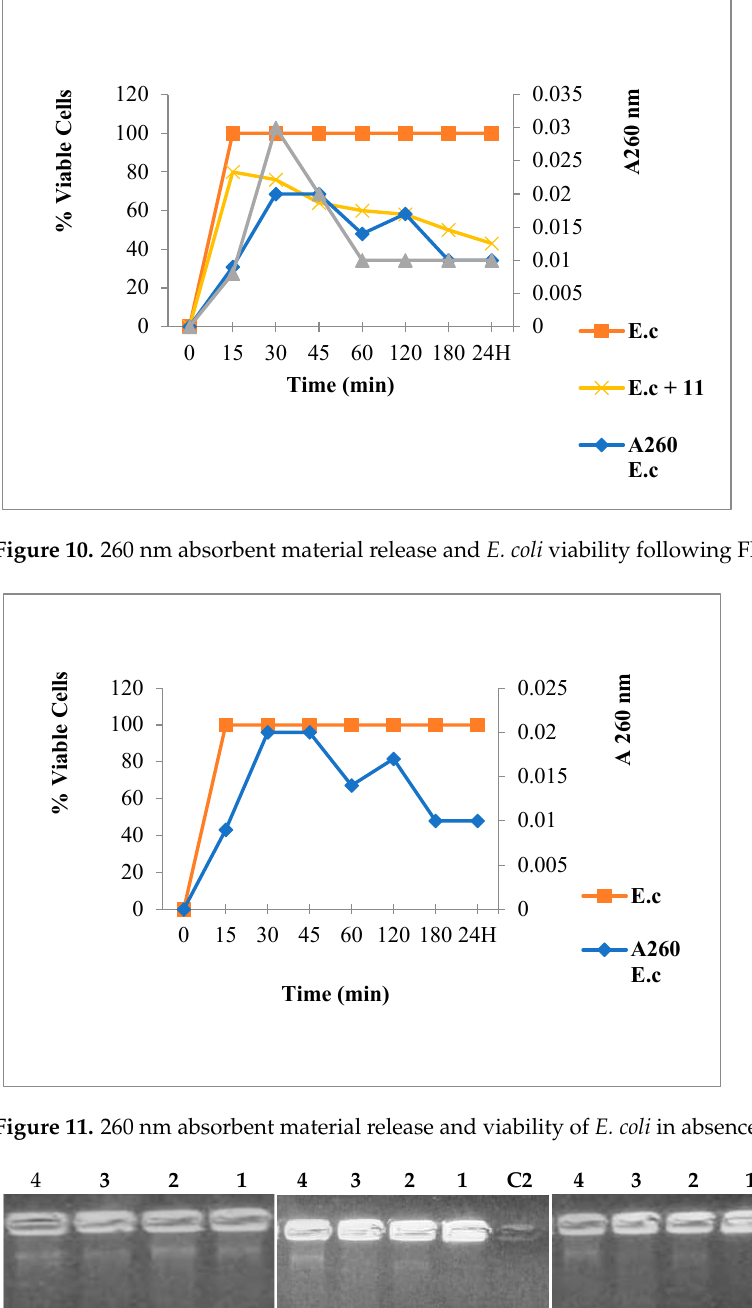
Figure 9. 260 nm absorbent material release and E. coli viability following Flavanone 8 treatment.